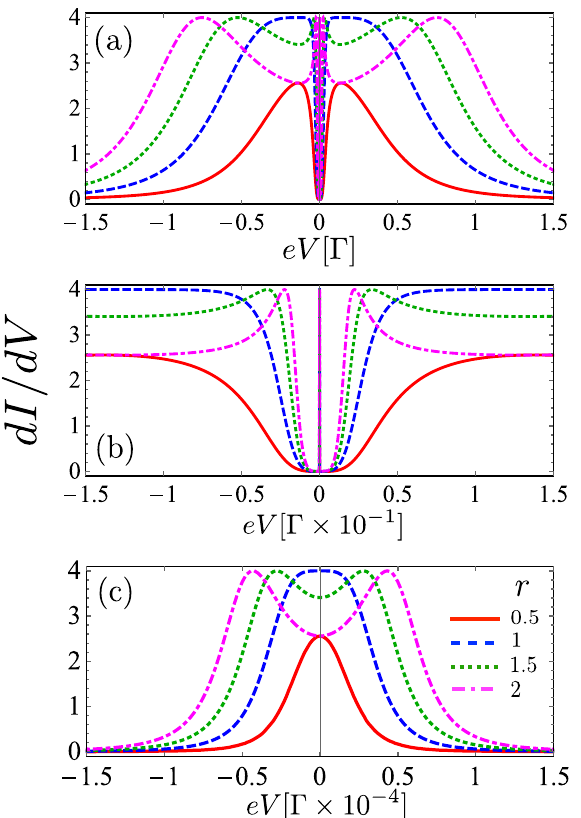
Figure 2. Differential conductance in the noninteracting case, calculated as a function of the bias voltage 1.5 ( green ) , r 2.0 ( magenta ) . Fixed 0 and indicated values of r : r 0.5 ( red ) , r 1.0 ( blue ) , r when ǫ d = = = = = 0.1 Ŵ . ( b ) Closeup of central peak presented in panel ( a ). ( c ) Closeup of central 0.001 Ŵ , t parameters: η = = peak presented in panel ( b